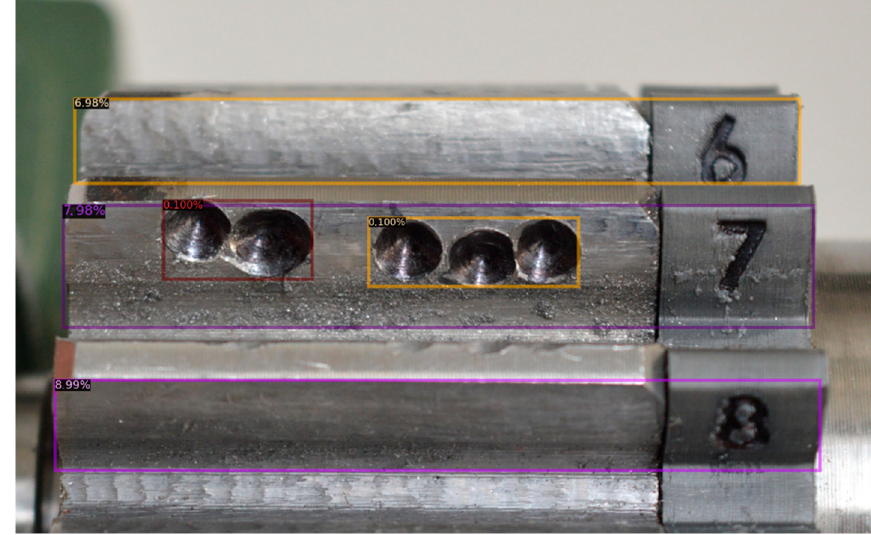
Figure 5. Output image of the gear with greater pitting damage. Table 1. Results of output images for Pitting 1 and 2, and Tooth 7.